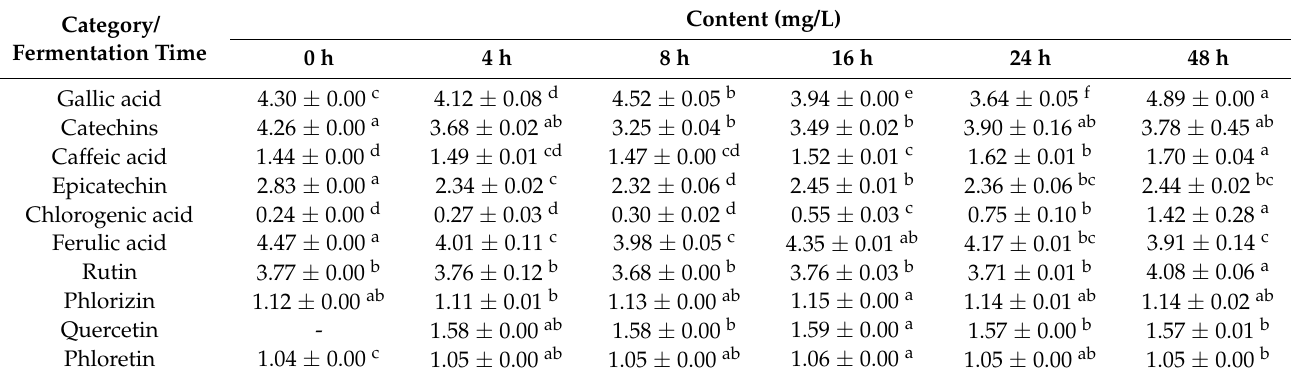
Table 2. Variations in polyphenolic profiles of 200 MPa treated apple juice during fermentation.